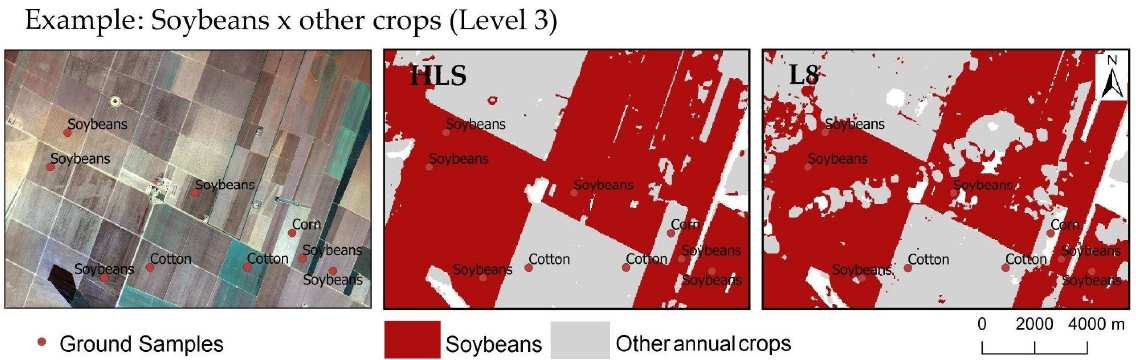
Figure 8. Level 3 classification example illustrates the potential of the HLS time series, denser than L8, in distinguishing soybean from other annual crops even with a very high occurrence of clouds during the key periods of the season. In Western Bahia, the lack of optical remote sensing data due to cloud cover still is one of the main challenges of crop monitoring and it became evident, especially in the L8 map.